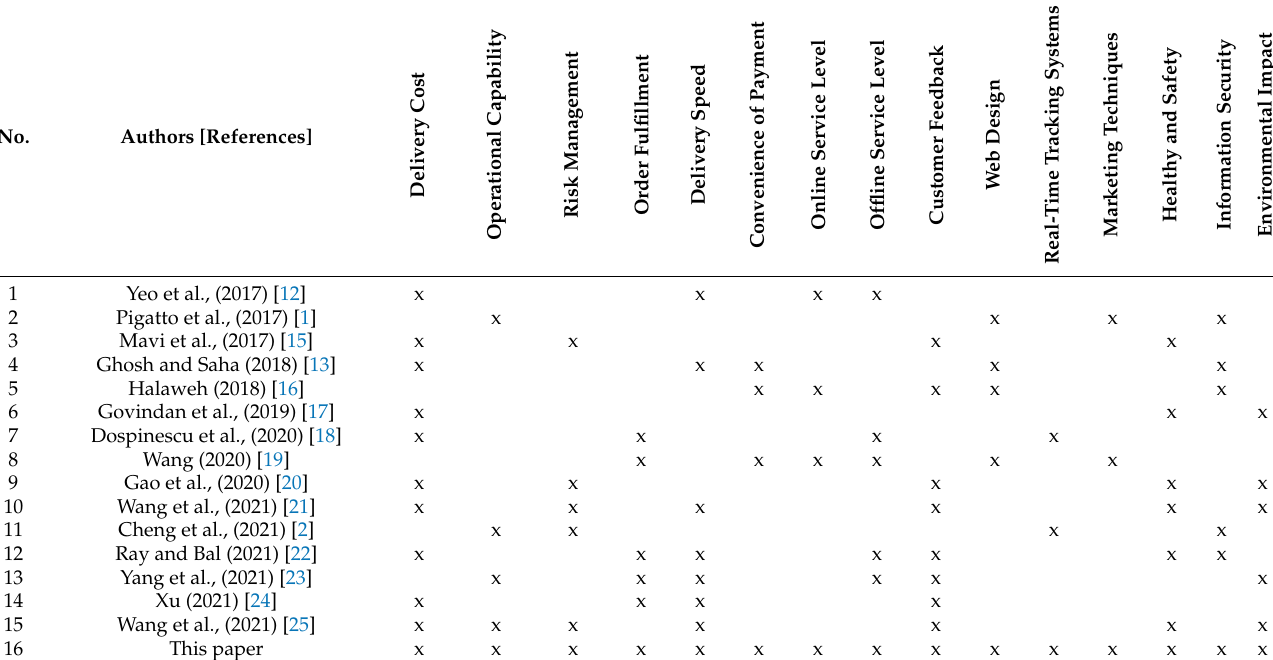
Table 1. The list of criteria used in related previous